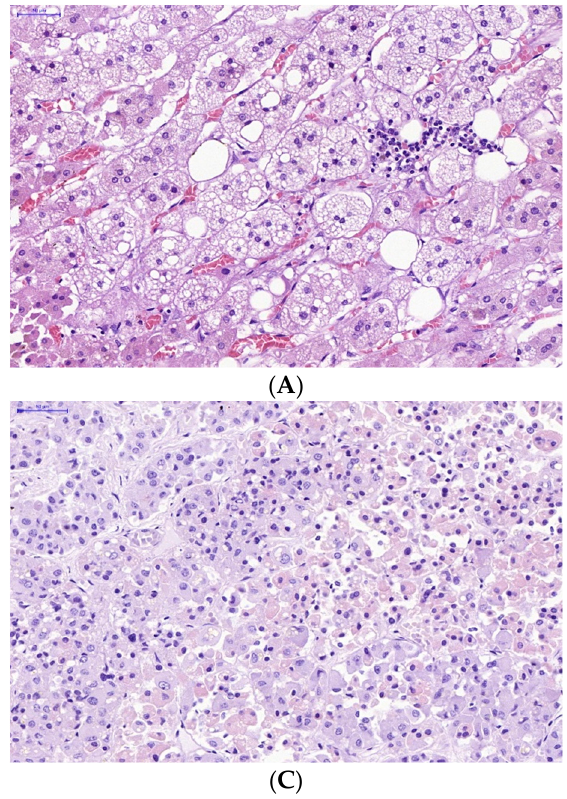
Figure 3. Lymphocyte infiltration in stroma and parenchyma of some endocrine organs in victims of lethal COVID-19. ( A —adrenal gland, B —thyroid gland, C —pituitary gland) ( A – C )—H&E. Scale bar length: ( A – C )—50 μ m).